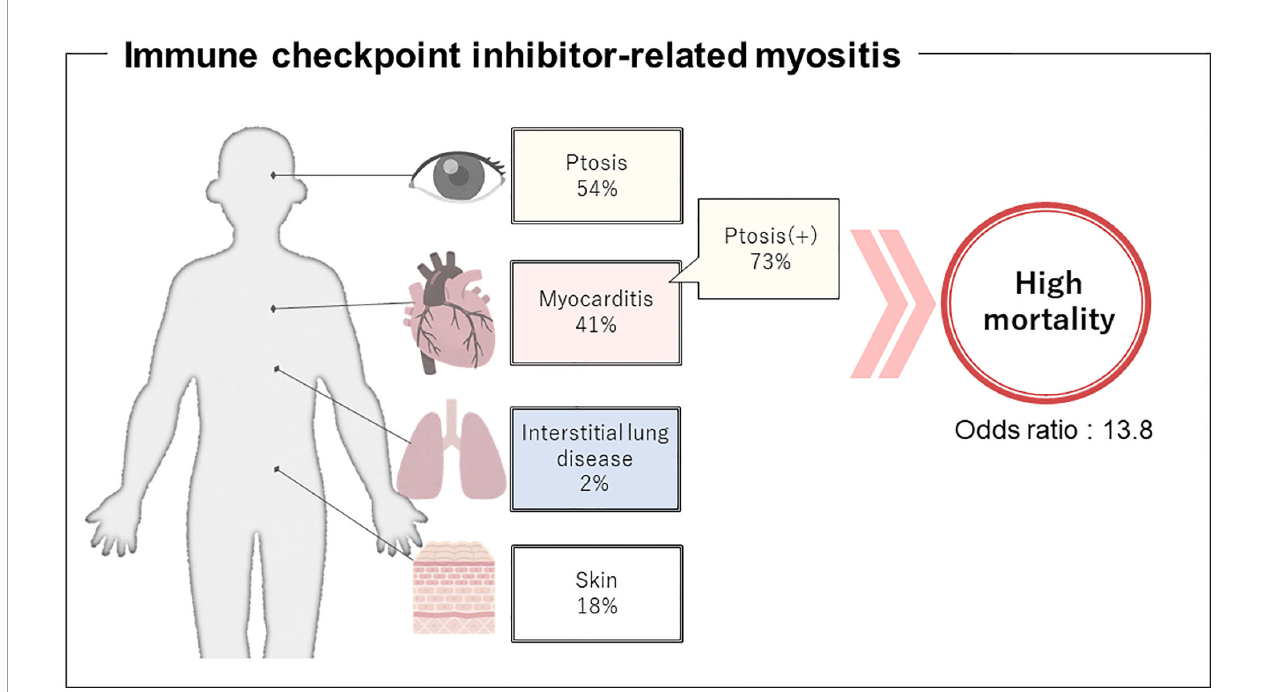
FIGURE 3 | Presumptive clinical features regarding immune checkpoint inhibitor-related myositis. Development of concomitant myocarditis might be predicted by ptosis, therefore, can help prevent the potentially fatal